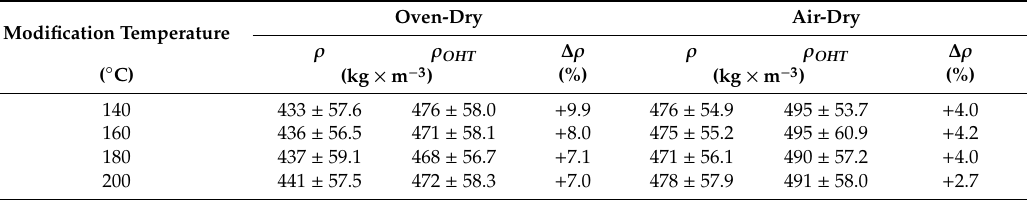
Table 1. Mean value of spruce wood density before and after modification, at di ff erent temperatures and moisture content; ±